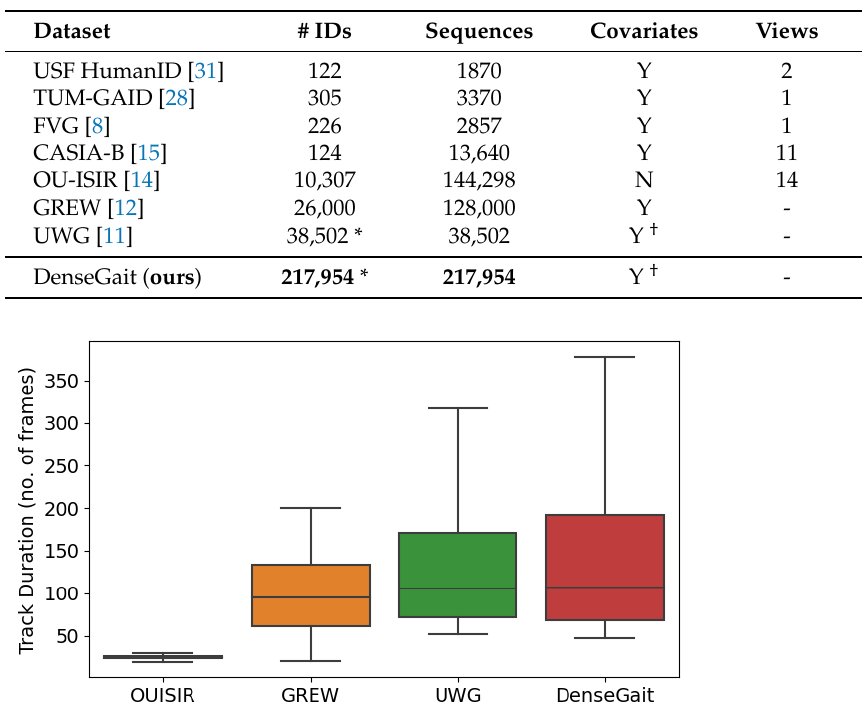
Table 2. Comparison of popular datasets for gait recognition. DenseGait is an order of magnitude larger, has more identities in terms of skeleton sequences (highlighted in bold ), and each sequence is annotated with 42 appearance attributes. * Approximate number given by pose tracker. † Implicit covariates across tracking duration.